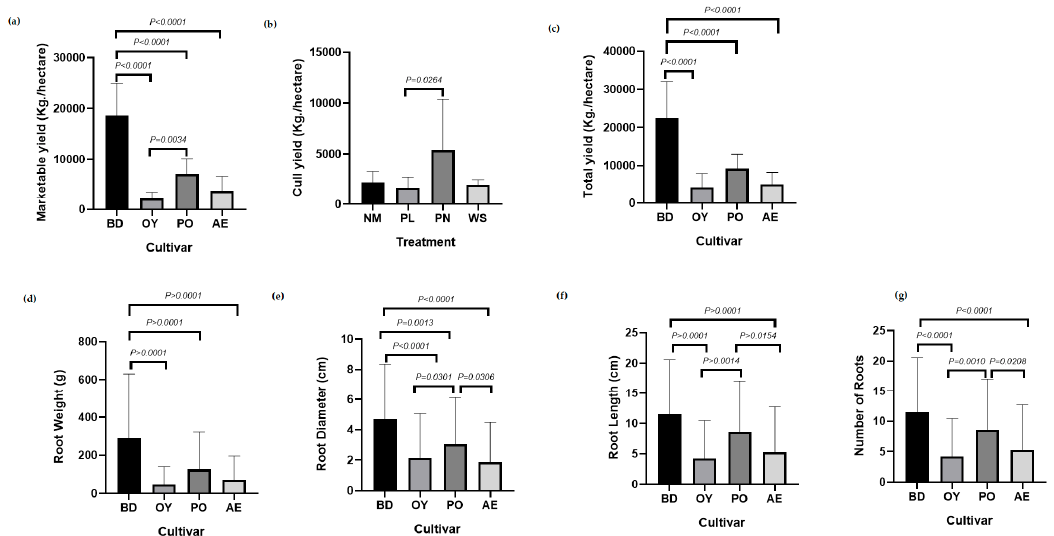
Figure 5. Root diameter, length, and number in sweetpotato cultivars: Beauregard (BD), O’ Henry (OY), Porto Rico (PO) and All Purple (AE) in various mulch treatments: No mulch (NM), Black Plastic Mulch (PL), Pine Needle Mulch (PN) and Wheat Straw Mulch (WS). ( a ) Marketable yields amongst sweetpotato cultivars, ( b ) Cull yields in various mulch treatments, ( c ) Total yields amongst sweetpotato cultivars, ( d ) Root weight for each sweetpotato tuber, ( e ) Root length of each sweetpotato tuber, ( f ) Root diameter of each sweetpotato tuber ( g ) Number of Sweetpotato roots.